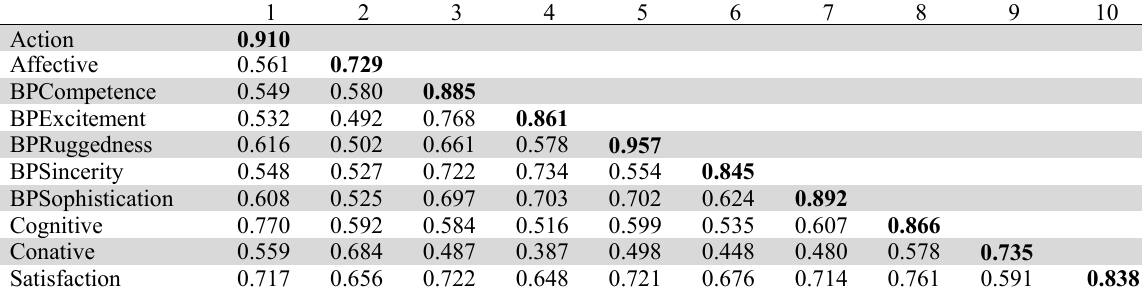
Latent variable correlations and square roots of average variance extracted